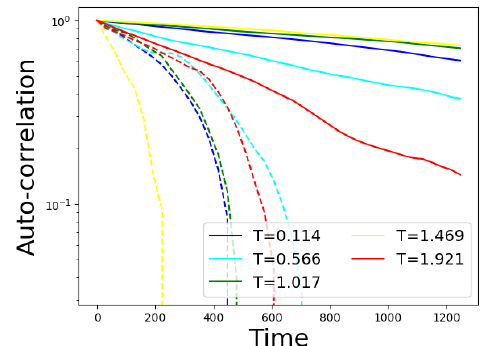
Figure 7: Characteristics of our ImplicitGAN- E